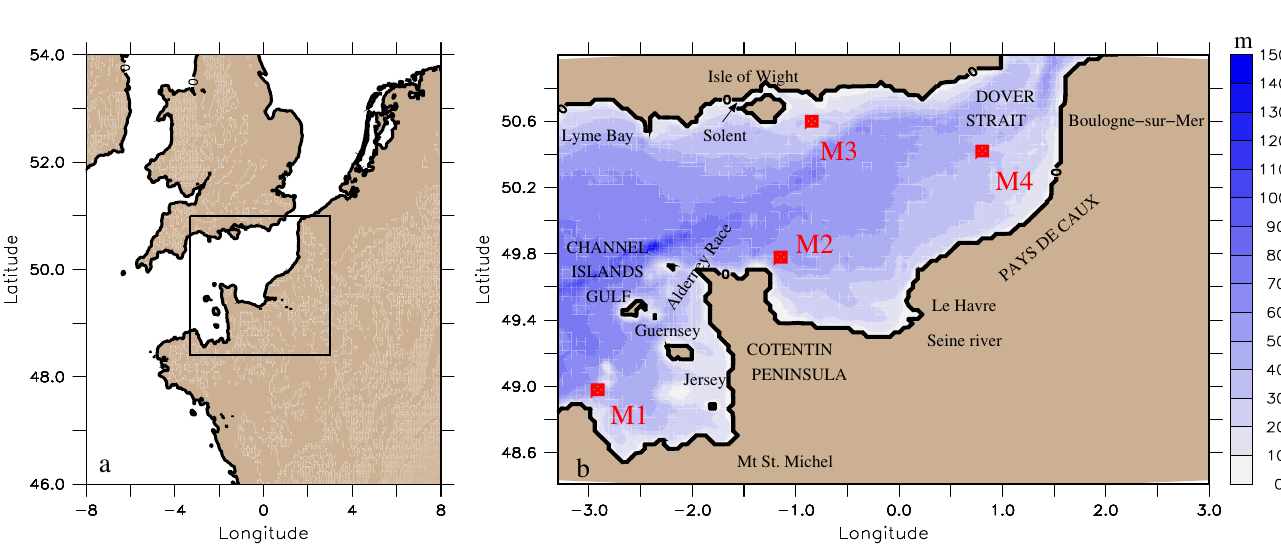
Figure 1. ( a ) Location of the English Channel on the northwestern European continental shelf; ( b ) Bathymetry of the computational domain with the locations of Points M1–M4.